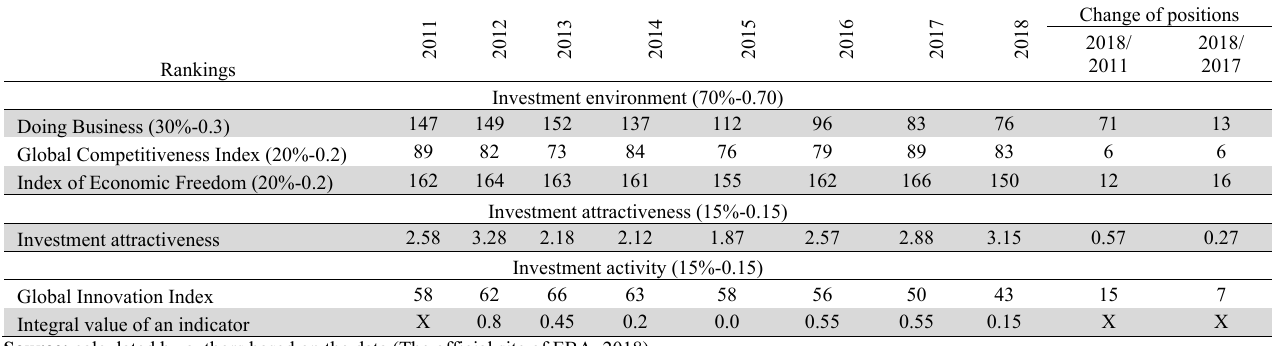
Assessment of the integral value of investment climate international rankings for Ukraine